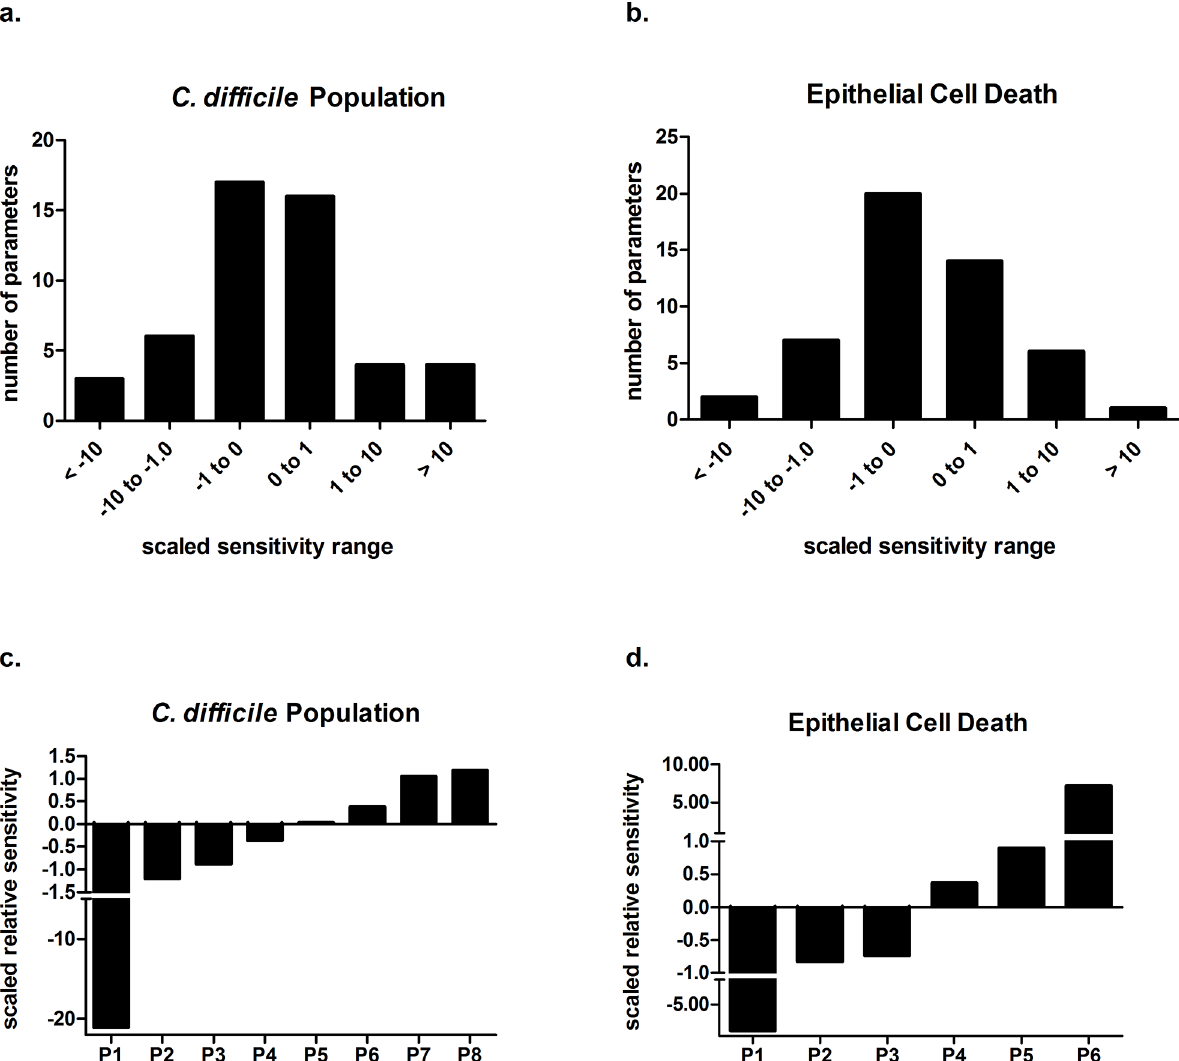
Fig 4. Relative effects of parameters on Clostridium difficile population and epithelial cell death. (a and b) Histograms showing the distribution of parameter impact on C . difficile population and epithelial cell death, respectively. Measurements are based on sensitivity analysis of the calibrated model. (c and d) Highest impact parameters for each quantity in which positive amounts indicate an increasing effect on the quantity and negative amounts indicate a decreasing effect. For the C . difficile population results, P1 contributes to effector dendritic cell production, P2 to neutrophil activation and migration, P3 to protective commensal bacteria regrowth, P4 to macrophage activation, P5 to commensal bacteria death, P6 to macrophage death, P7 to Th17 cell death, and P8 to neutrophil death. For epithelial cell death, P1 contributes to tolerogenic dendritic cell production, P2 to Th17 to Treg cell plasticity, P3 to commensal bacteria death, P4 to Treg to Th17 cell plasticity, P5 to macrophage activation and P6 to C . difficile growth.